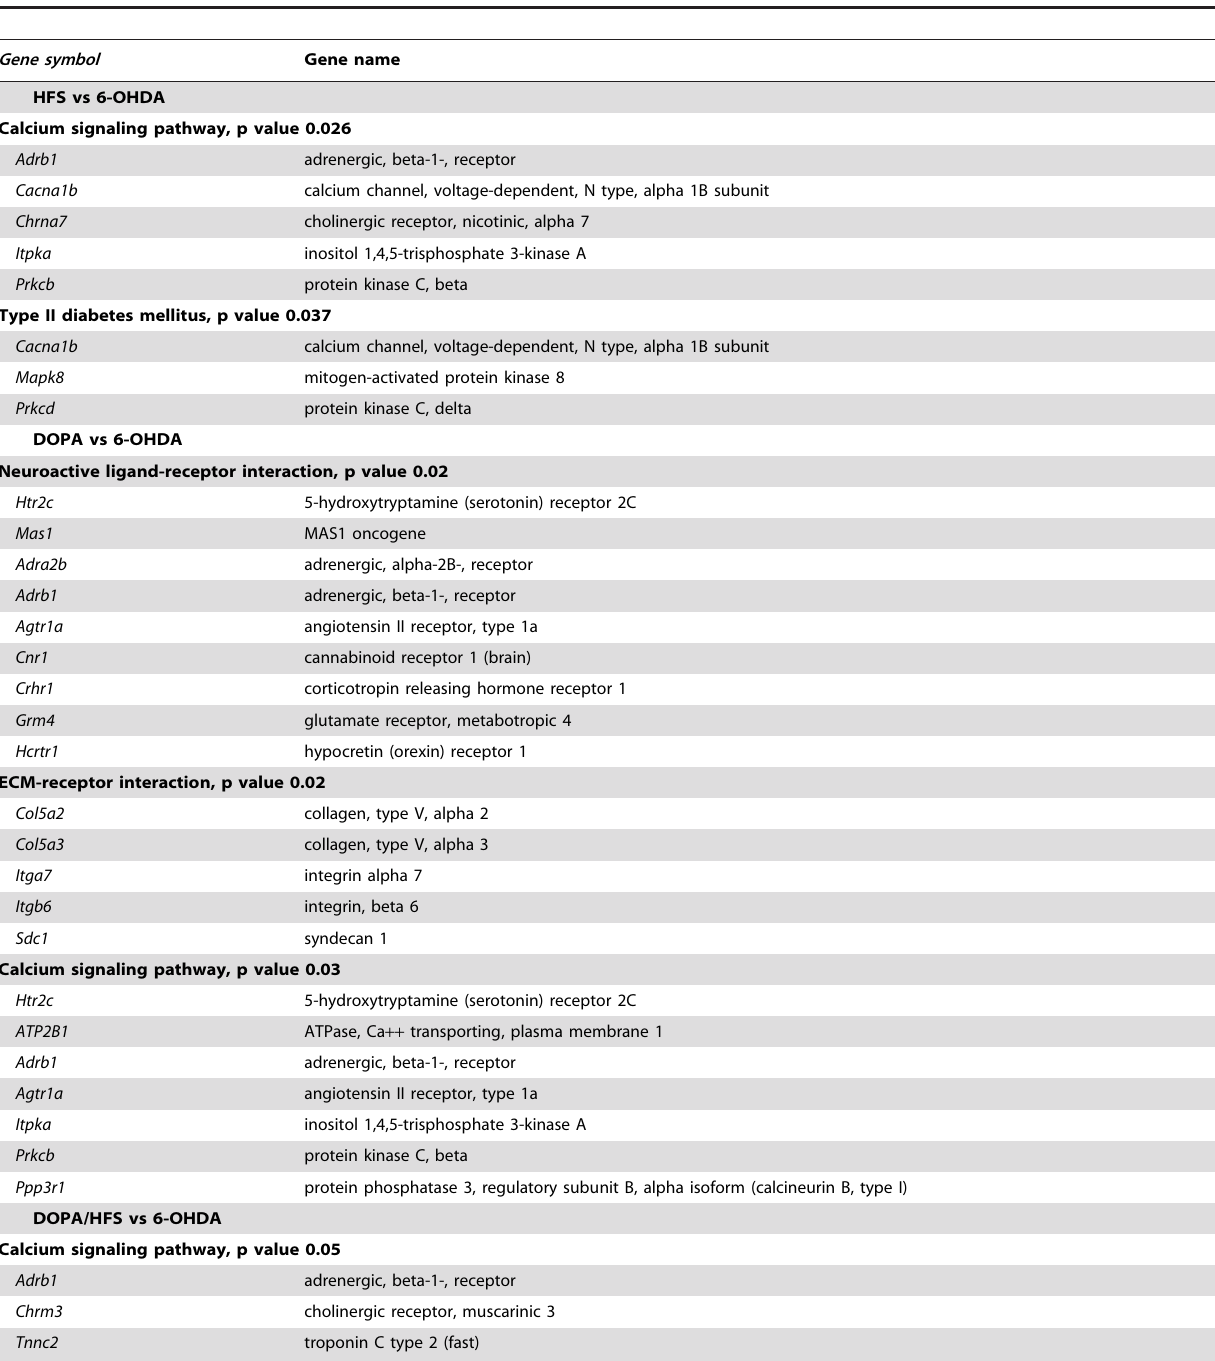
Table 2. KEGG metabolic pathways for genes differentially regulated in HFS, DOPA and DOPA/HFS groups vs 6-OHDA.